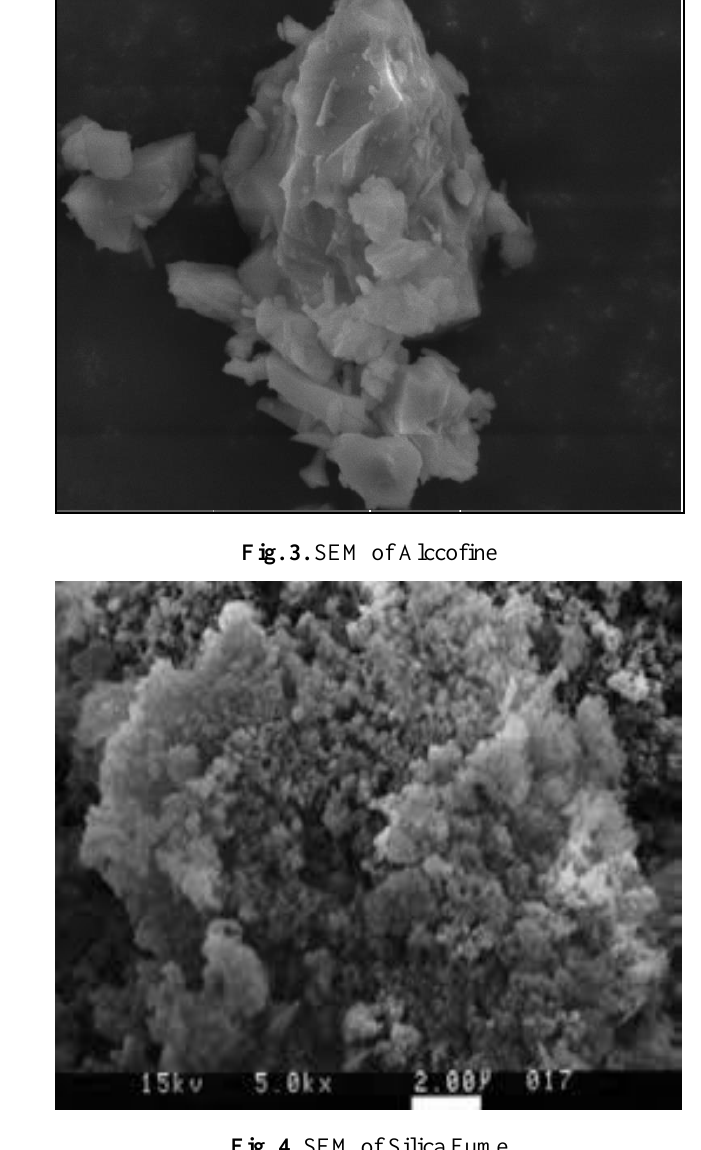
Fig. 4. SEM of Silica